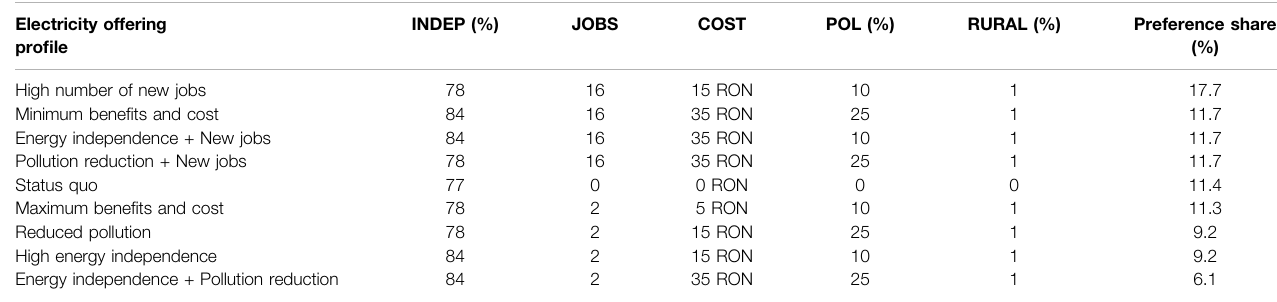
TABLE 10 | Market/preference share simulation for competing electricity